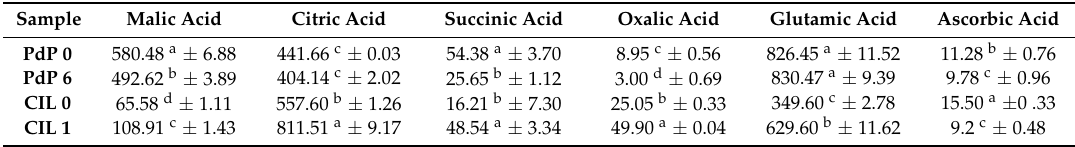
Table 4. Mean and standard deviation of organic acids (mg/100 g fresh weight)